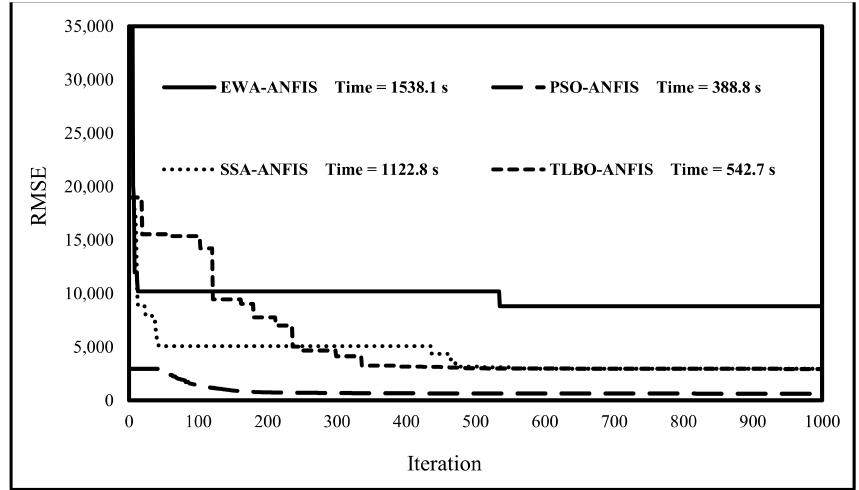
Figure 3. Metaheuristic-based optimization curves of the ANFIS.